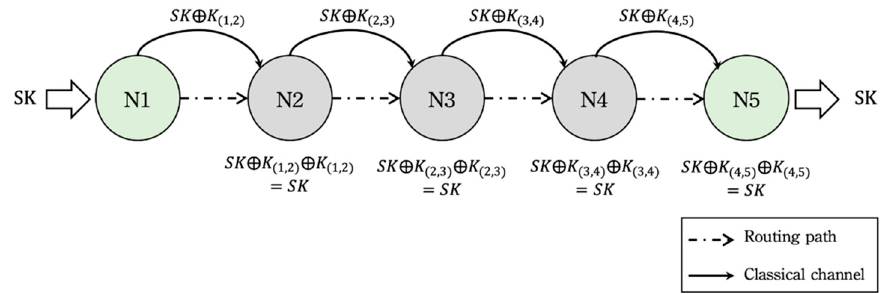
Figure 6. Session key transmission method in the SECOQC QKD network.